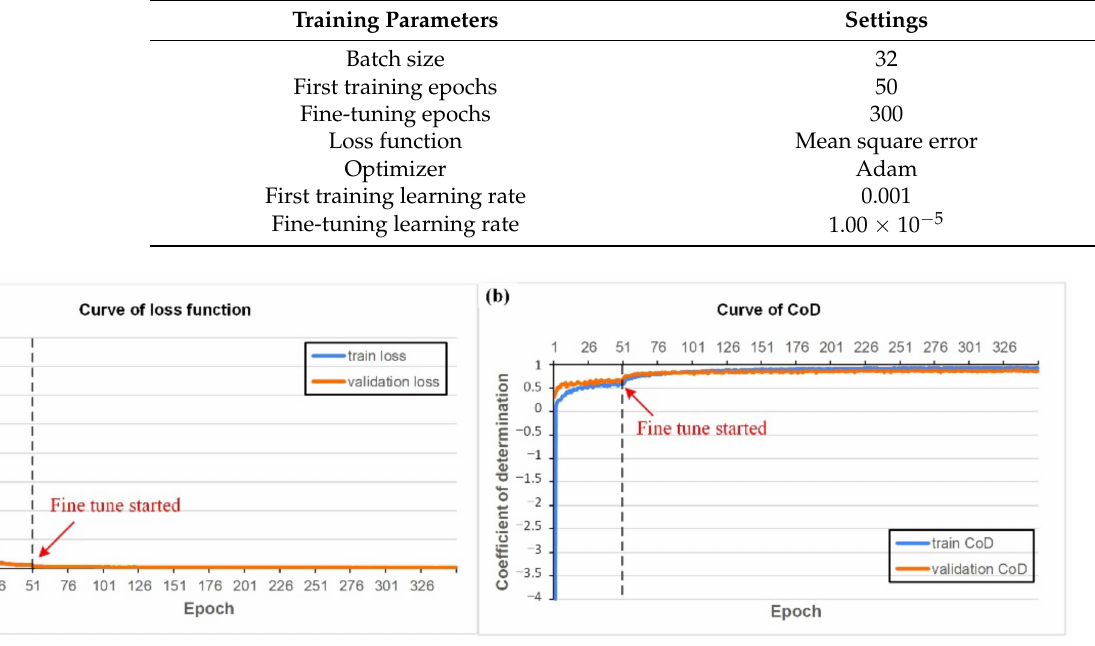
Figure 16. The loss ( a ) and coefficient of determination ( b ) of the model for the second task.